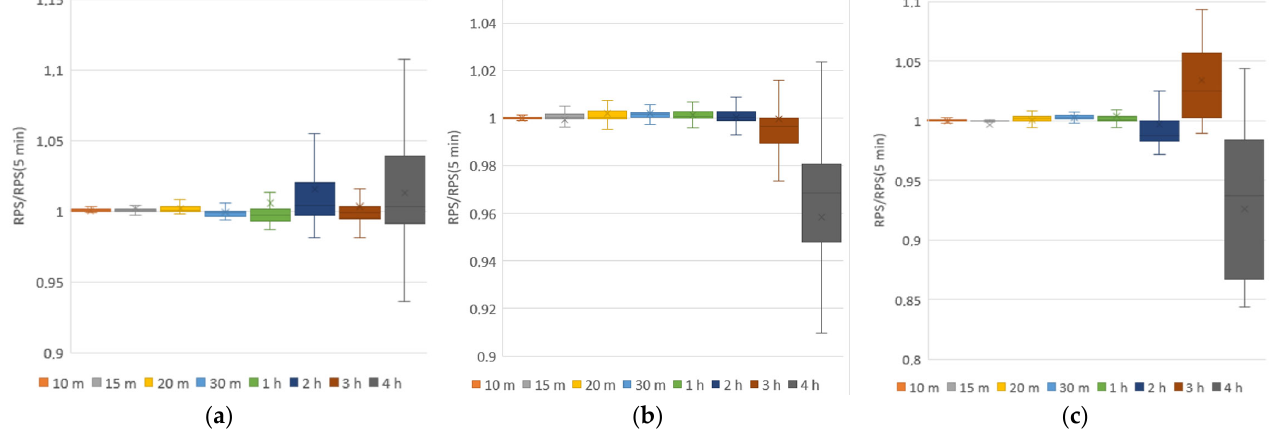
Figure 7. Diagrams of RPS for ( a ) 23005, ( b ) 39352 and ( c ) 47647 station ID’s. Three ‐ month datasets.